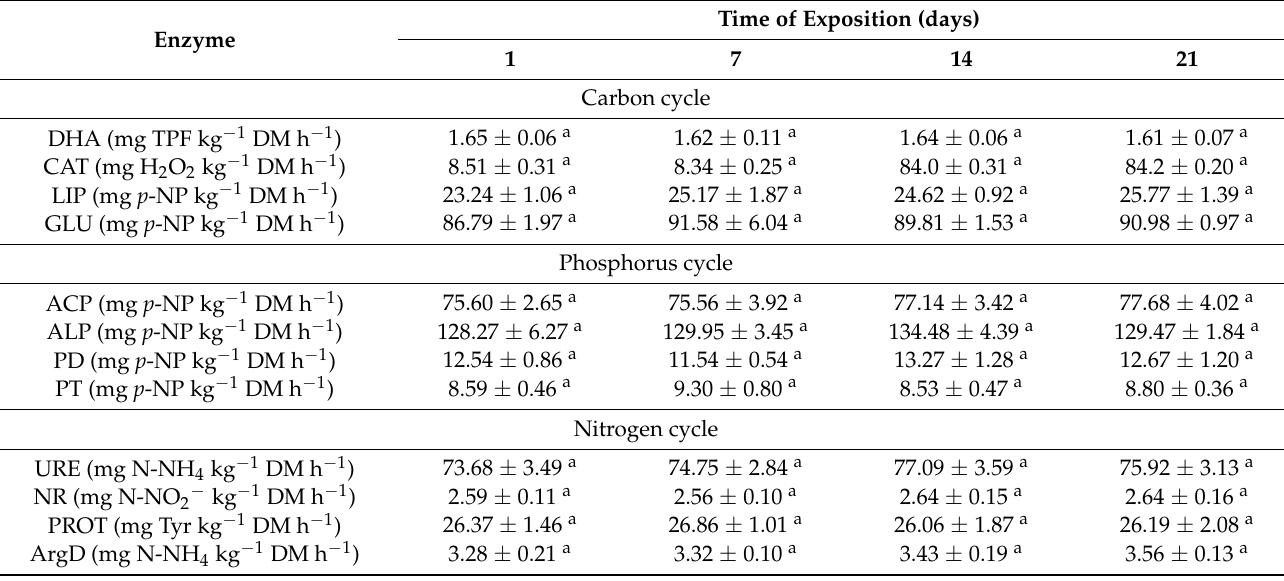
Table 2. Activity of enzymes in the soil not exposed to tetrabutylphosphonium bromide [TBP][Br] in pot experiment with spring